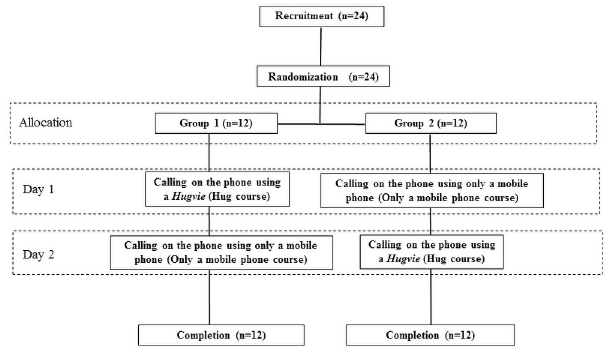
Fig 2. Participant recruitment flowchart. Initially, the participants were randomly assigned to two groups: Group 1 talked on the phone using a Hugvie on Day 1 and used only a mobile phone on Day 2, while Group 2 talked on the phone using only a mobile phone on Day 1 and talked on the phone using a Hugvie on Day 2. All participants completed the trial procedures.